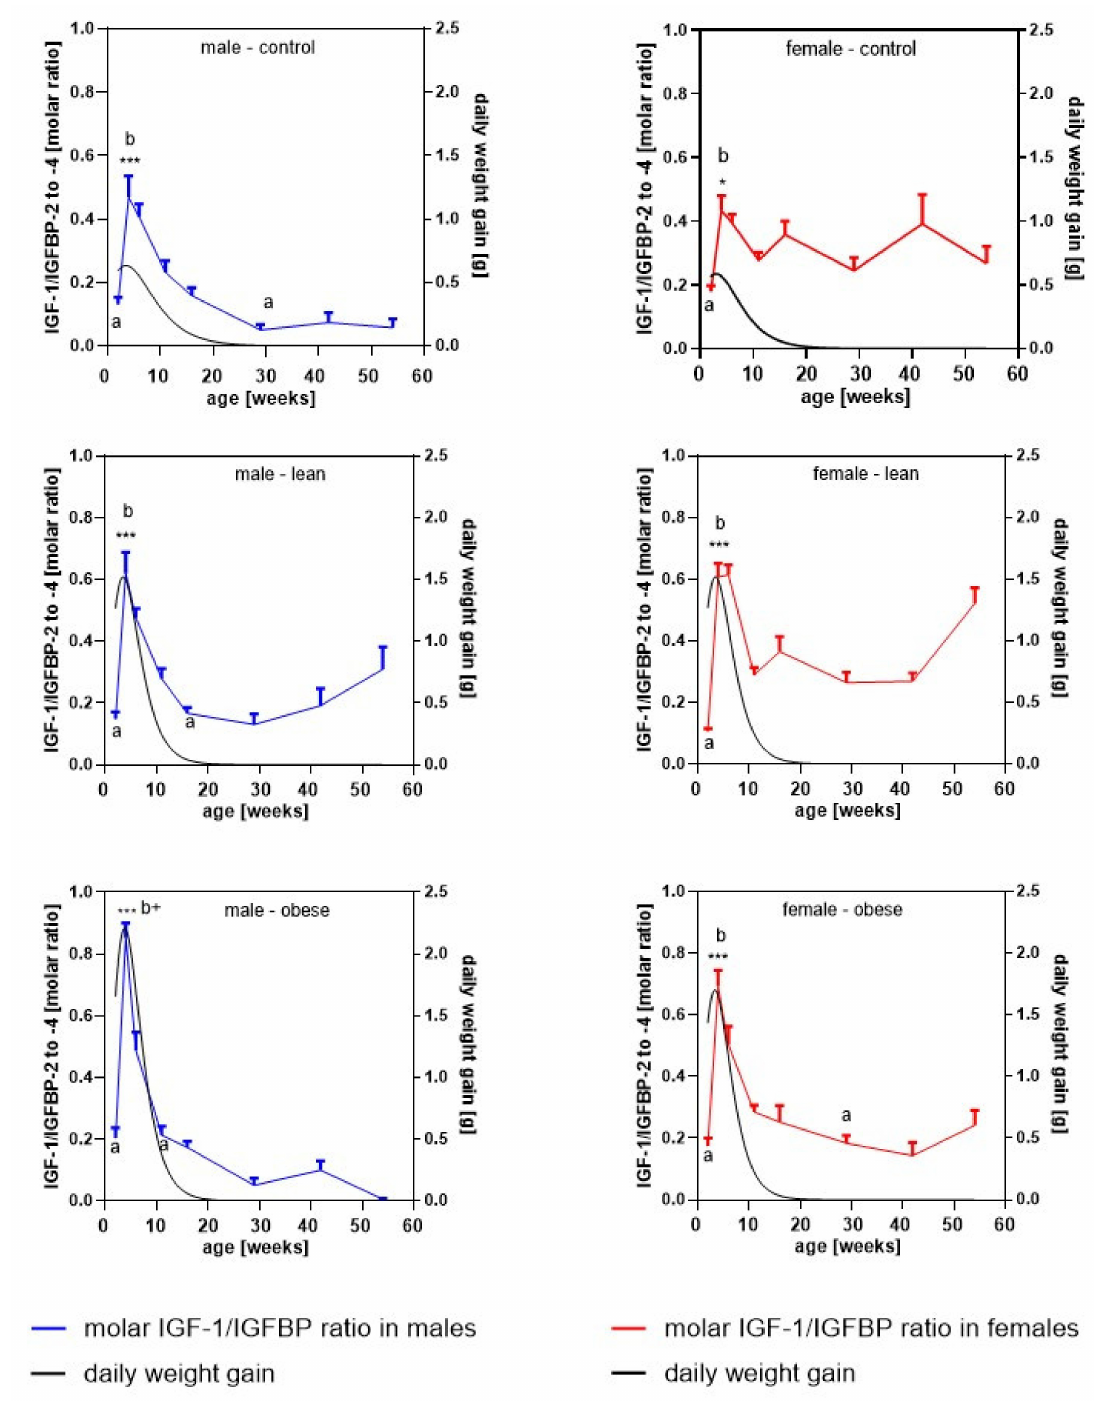
Figure 5. Molar ratio of IGF-1 to the sum of IGFBP-2, -3, and -4 (left Y-axis) present in serum from mice selected for high body weight (obese), for high protein amount (lean), and in unselected controls at an age of 2, 4, 7, 11, 16, 29, 42, and 54 weeks ( n ≥ 7 with the exception of obese male at 54 weeks with n = 4; di ff erent letters indicate significant e ff ects of age; identical letters indicate no statistically significant di ff erence; *: p < 0.05; ***: p < 0.001; b + : significantly di ff erent if compared to unselected controls, with p < 0.001 for males and p < 0.05 for females). On the right Y-axis, daily weight increases, intrapolated from the body weight data in Figure 1 by the Gompertz function, were